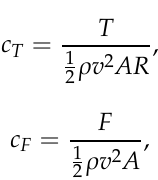
Figure 6. Comparison between the zero net flow rate gust shape function and the “extreme operating gust” from the 61400-IEC standards for wind turbines.